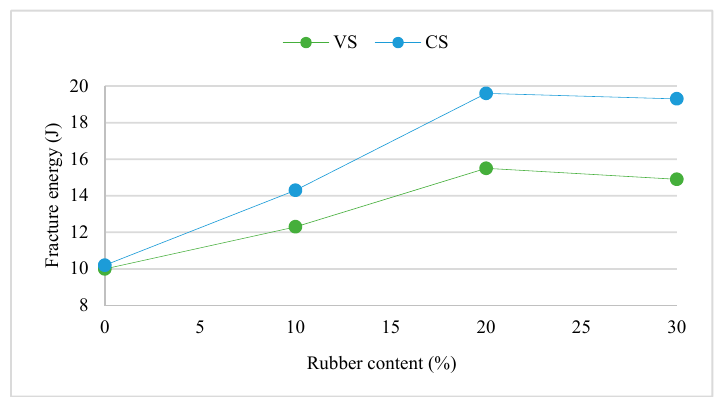
Figure 7. Relationship between fracture energy and rubber replacement level [45]. Reproduced with permission from A. Moustafa, M. ElGawady, Dynamic Properties of High Strength Rubberized Concrete; published by American Concrete Institut (ACI), Special Publication, 2017.